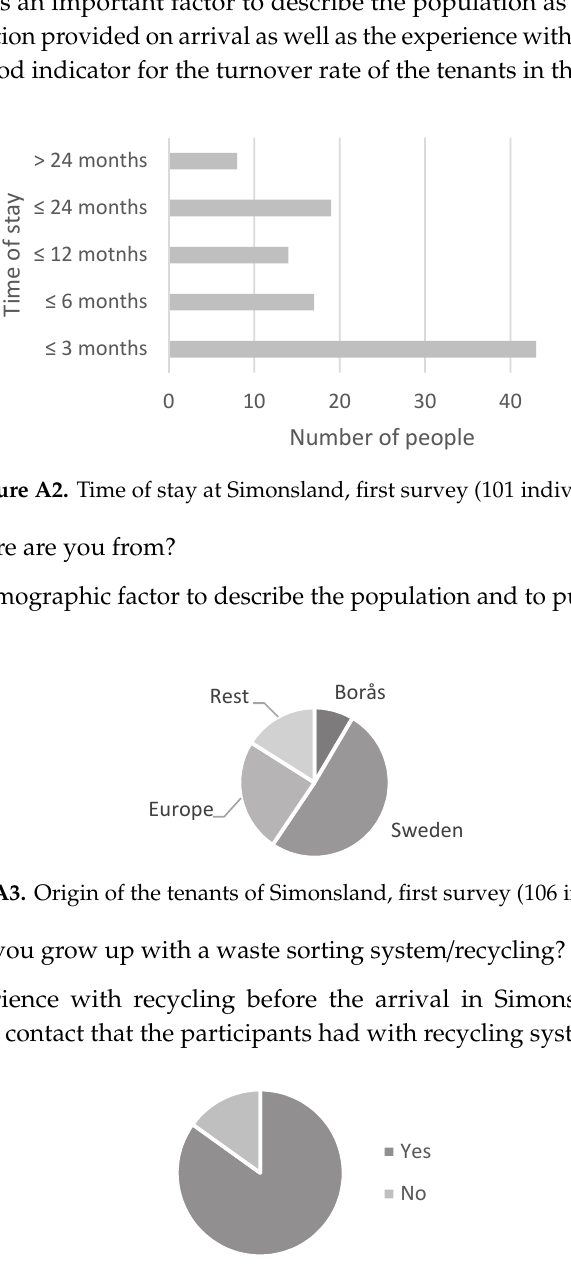
Figure A1 . Age distribution in the population, first survey (106 individuals).